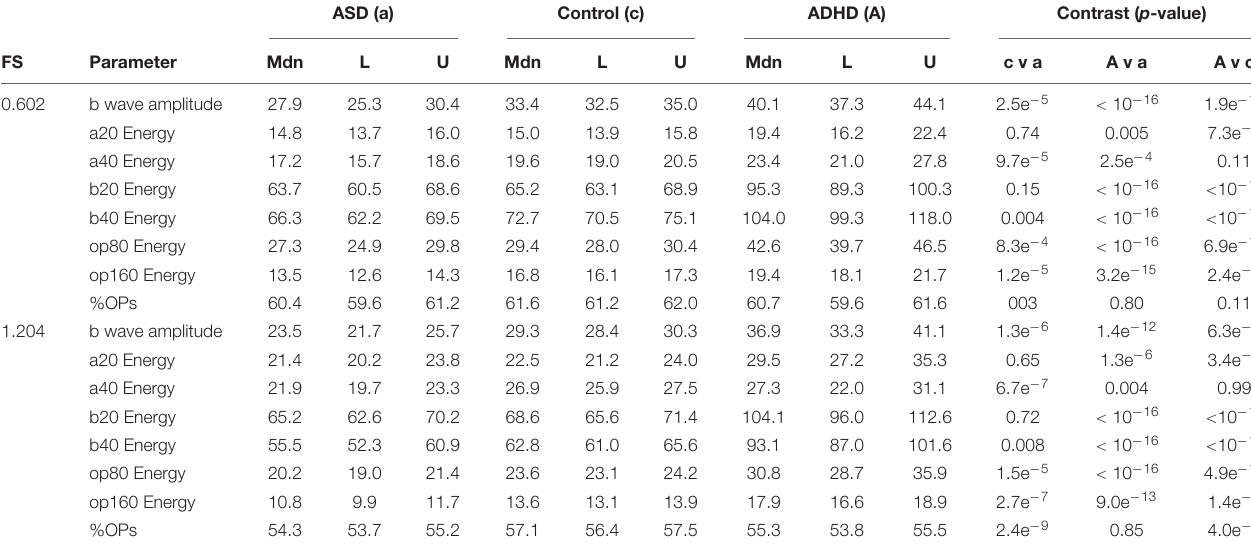
TABLE 1 | Median (Mdn) and lower (L) and upper (U) 95% confidence intervals for the three groups (ASD) autism spectrum disorder, control, and attention deficit hyperactivity disorder (ADHD) at each flash strength (FS) in log photopic cd.s.m − 2 . ASD (a) Control (c) ADHD (A) Contrast ( p